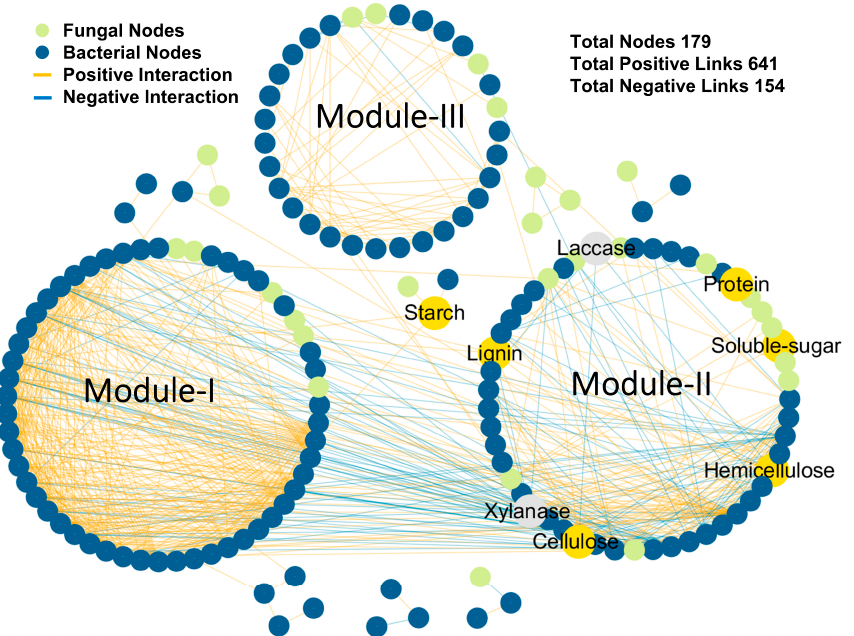
Figure 4. The co-occurrence network of microbial community in compositing. The orange and blue line indicate positive and negative interaction, respectively. The dark blue, green, yellow, and gray dot indicate bacterial member, fungal member, carbon source and enzyme, respectively.